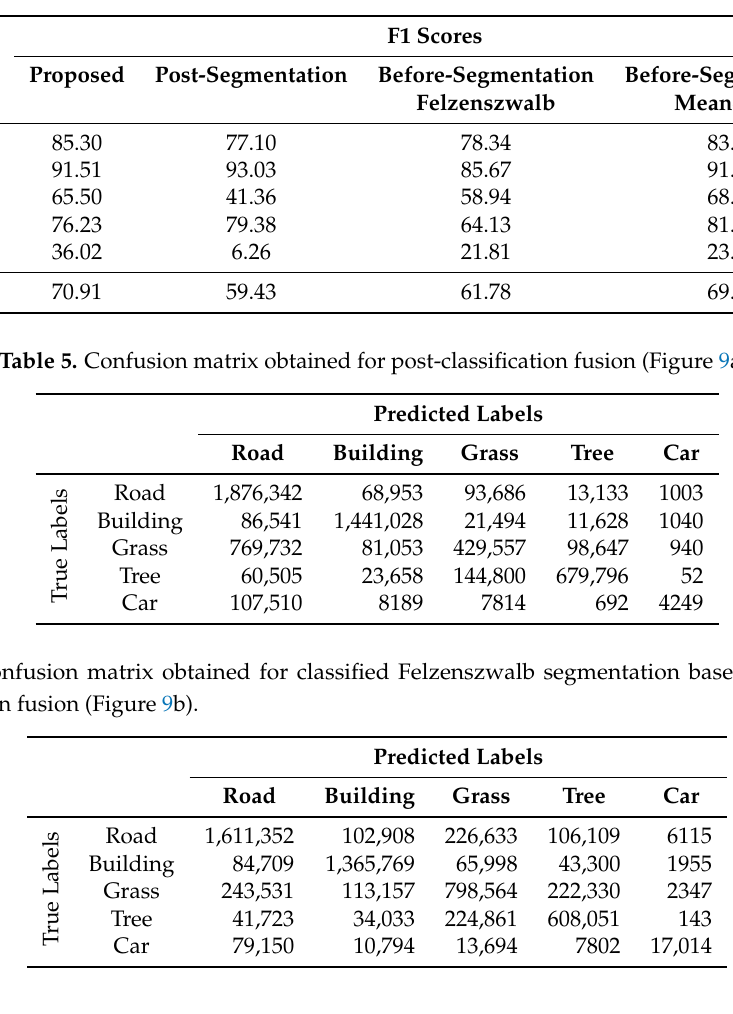
Table 4. F1 score of each class and average calculated using our proposed method and other fusion strategies (post- and before-segmentation, see Figure 9).